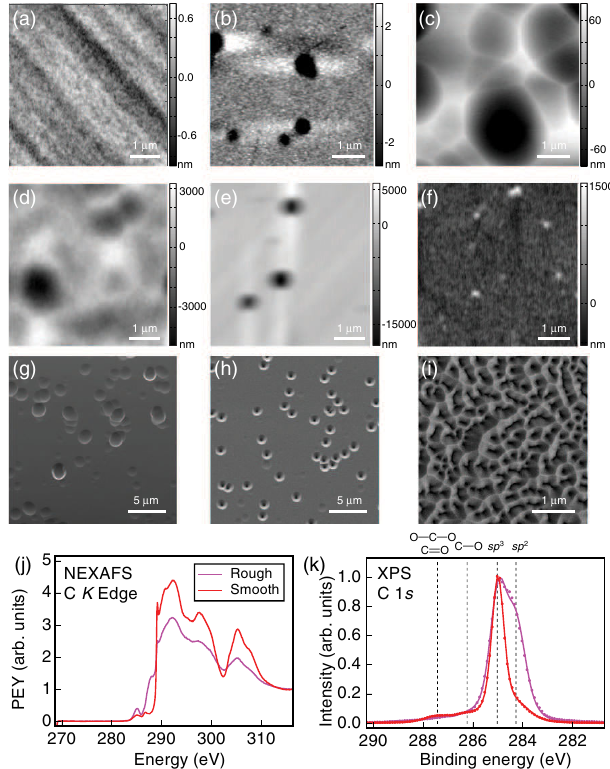
FIG. 8. (a) – (f) Representative AFM scans showing (a) smooth surface morphology and rough surfaces resulting from (b) con- tamination or surface damage during an oxygen anneal of a contaminated surface, (c) RIE etching after improper polishing, (d) RIE etching of a Na and Cl contaminated surface, (e) an oxygen anneal with uncontrolled gas purity, and (f) micromasking during an oxygen etch. (g) – (i) SEM images of large-scale morphology from a variety of damaged samples after reactive ion etching. (j) Carbon K -edge NEXAFS shows a comparison between a rough surface [purple, sample shown in (c)] and a smooth surface (red) that have both been triacid cleaned with the full process as described in the main text. (k) High-resolution carbon 1 s XPS spectra from the two surfaces. The rough surface shows a large nondiamond sp 2 carbon peak at lower binding polishing. Figures 8(j) and 8(k) show the NEXAFS and XPS spectra from this same sample after subsequent oxygen annealing, overlaid with spectra from a smooth diamond for comparison. Figure 8(j) shows a larger